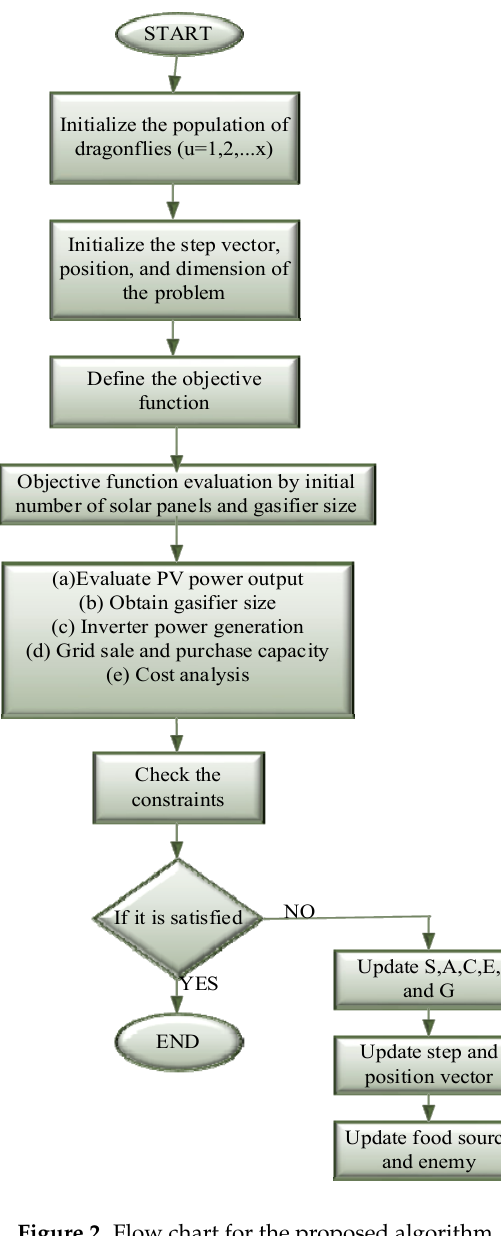
Figure 2. Flow chart for the proposed algorithm.